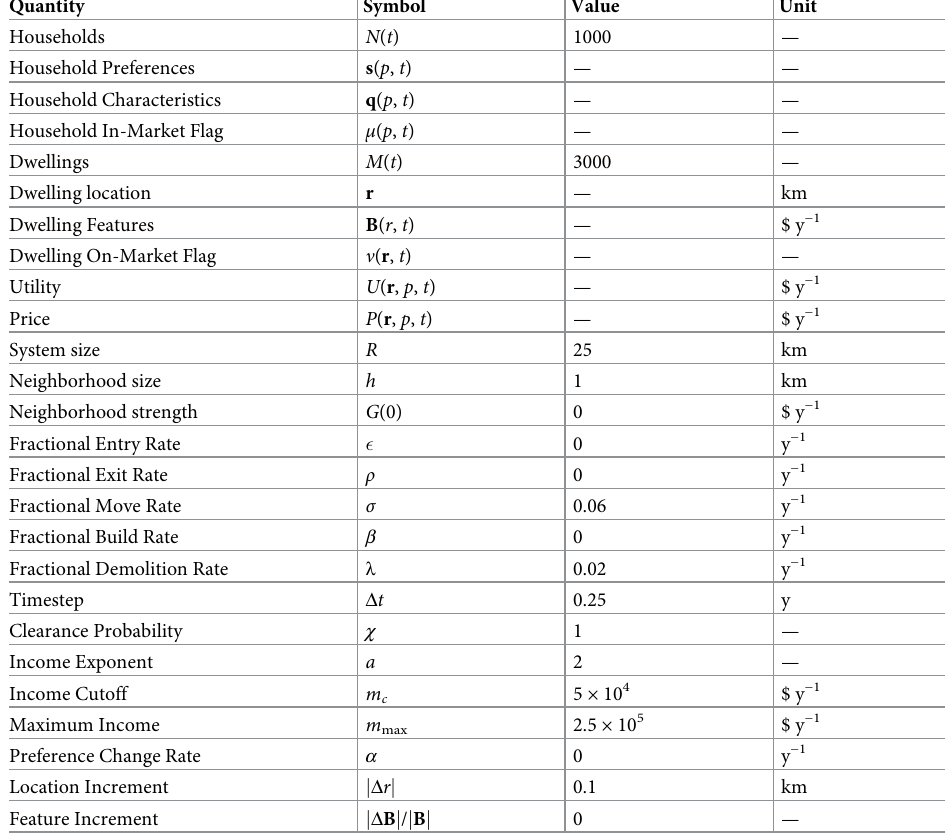
Table 1. Dynamic quantities and parameters shown above and below the line, respectively, with their symbols in the second column, nominal or initial values in the third, and units in the fourth, where $ denotes money. Dashes in the third column indicate values that depend on the details of the specific case chosen. Dashes in the final column indicate dimensionless